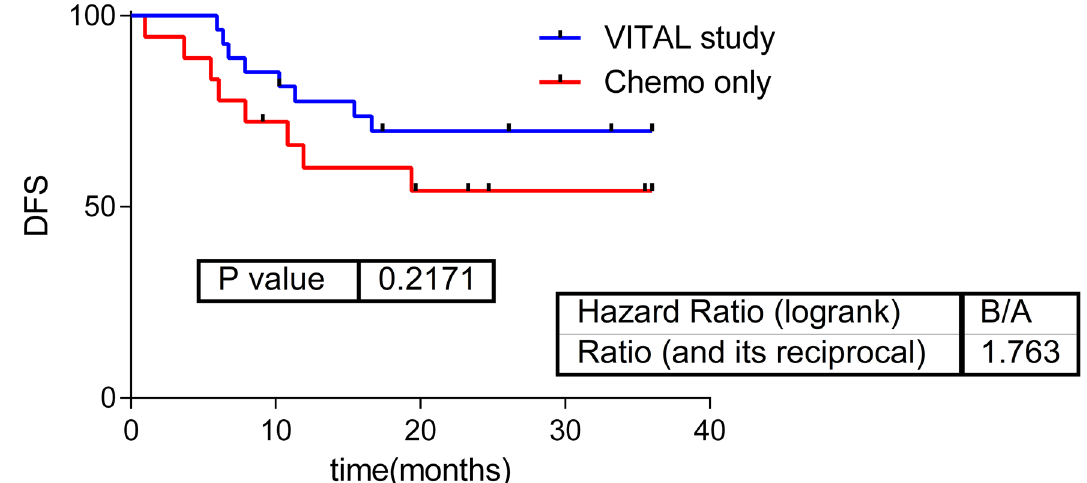
Figure 1. Survival curves. Survival curves in patients from the VITAL clinical trial treated with chemotherapy, radiotherapy, and panitumumab; and patients from daily clinical practice (treated only with chemotherapy plus radiotherapy). DFS Disease-free